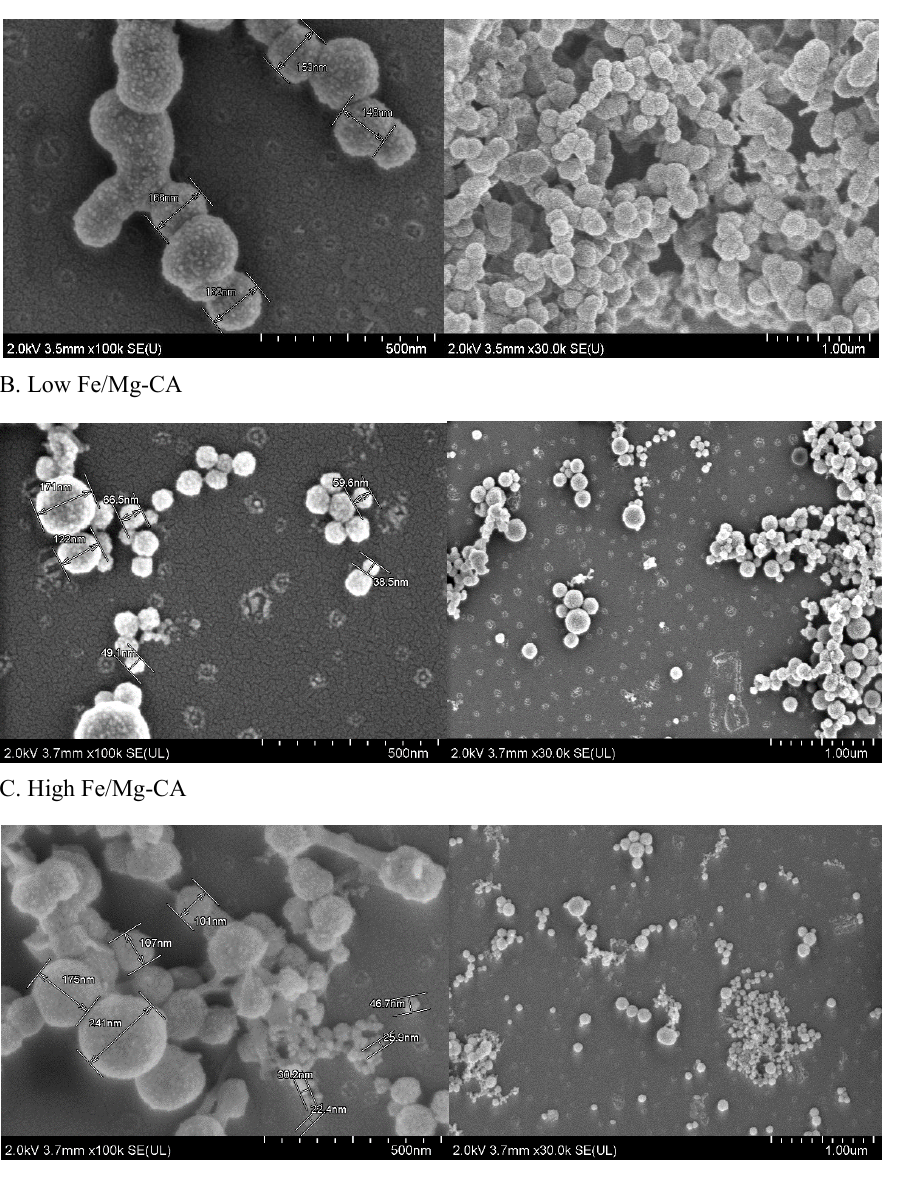
Figure 7. FESEM micrographs in presence of 10% FBS showing size, shape and surface morphology. Scale bar: 500 nm, and 1 µm. ( A ) CA ( B ) Low Fe/Mg-CA ( C ) High Fe/Mg-CA. After the respective particles were incubated and supplemented with 10% FBS, they were centrifuged twice for 15 min at 13,000 rpm. The supernatants were discarded and the pellets were resuspended in 20 µL Milli Q water. Then 3 µL of the respective NP suspensions was dried at room temperature for 45 min.